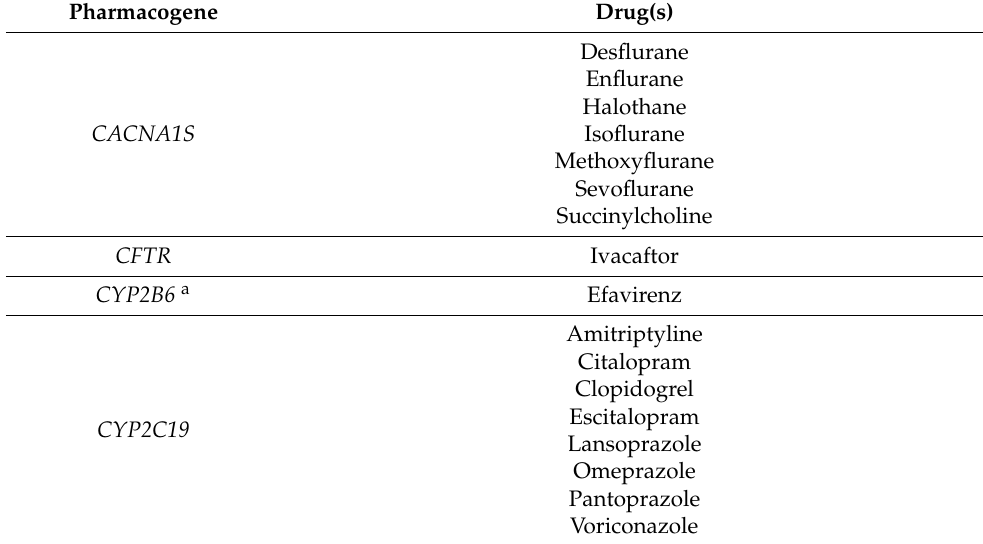
Table A3. Clinical Pharmacogenomics Implementation Consortium Level A Gene-Drug Pairs